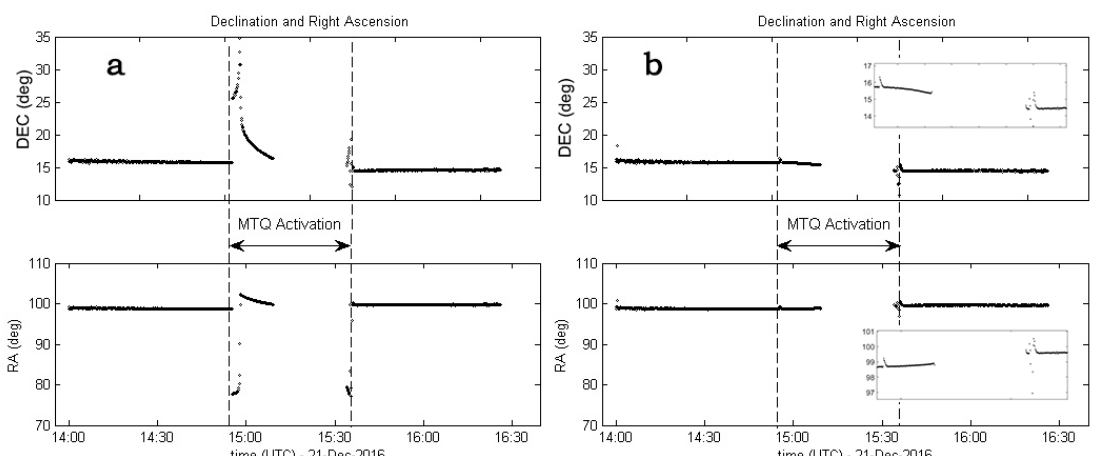
Figure 4. Coarse spin-axis estimation over third perigee pass (21 December 2016 about 15:00–15:30 UTC). ( a ) The results without real-time GAS bias correction. ( b ) The results with real-time GAS bias correction. Small plots on figure b shows the zoomed results for DEC and RA estimation starting from 1 min before the MTQ activation and ending at 15:45.